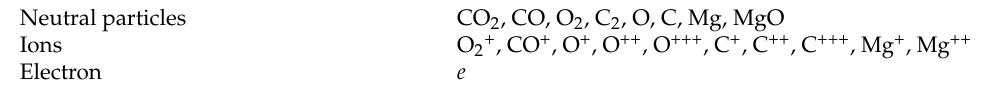
Table 1. The list of molecules in magnesium oxide crystal arc plasma.